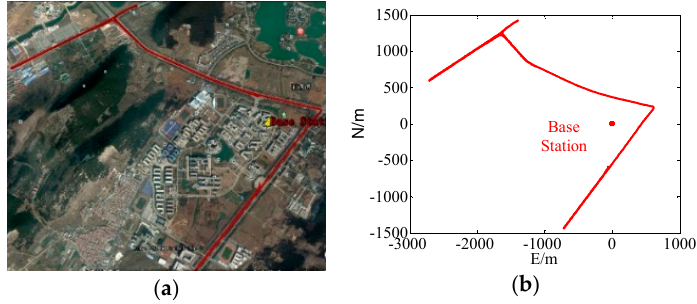
Figure 19. Movement trajectory. ( a ) The actual movement trajectory. ( b ) The simulated movement trajectory.